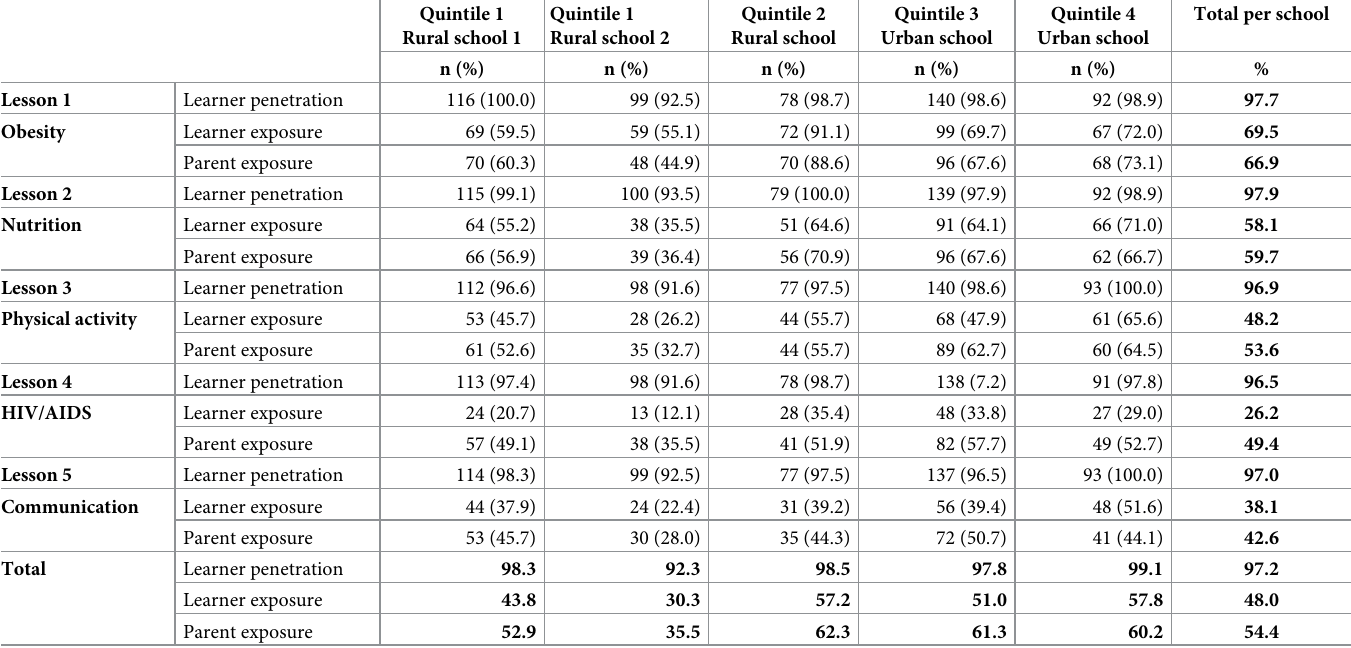
Table 3. Penetration and exposure by lessons and by